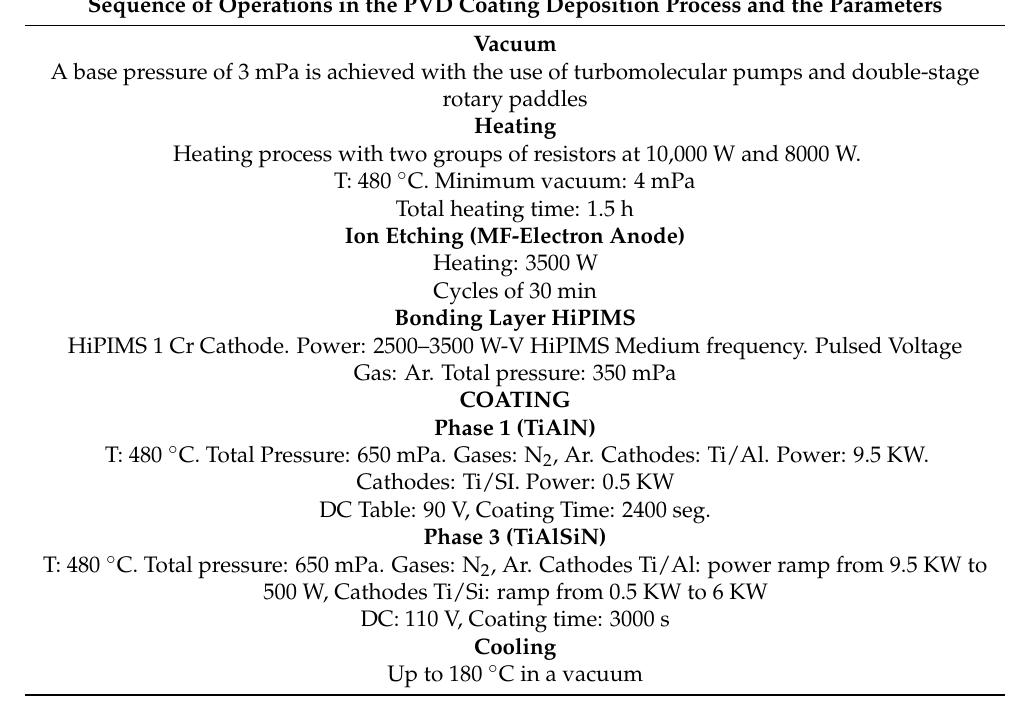
Table 2. Sequence of operations in the PVD coating deposition process and the parameters. Sequence of Operations in the PVD Coating Deposition Process and the Parameters Vacuum A base pressure of 3 mPa is achieved with the use of turbomolecular pumps and double-stage rotary paddles Heating Heating process with two groups of resistors at 10,000 W and 8000 W.